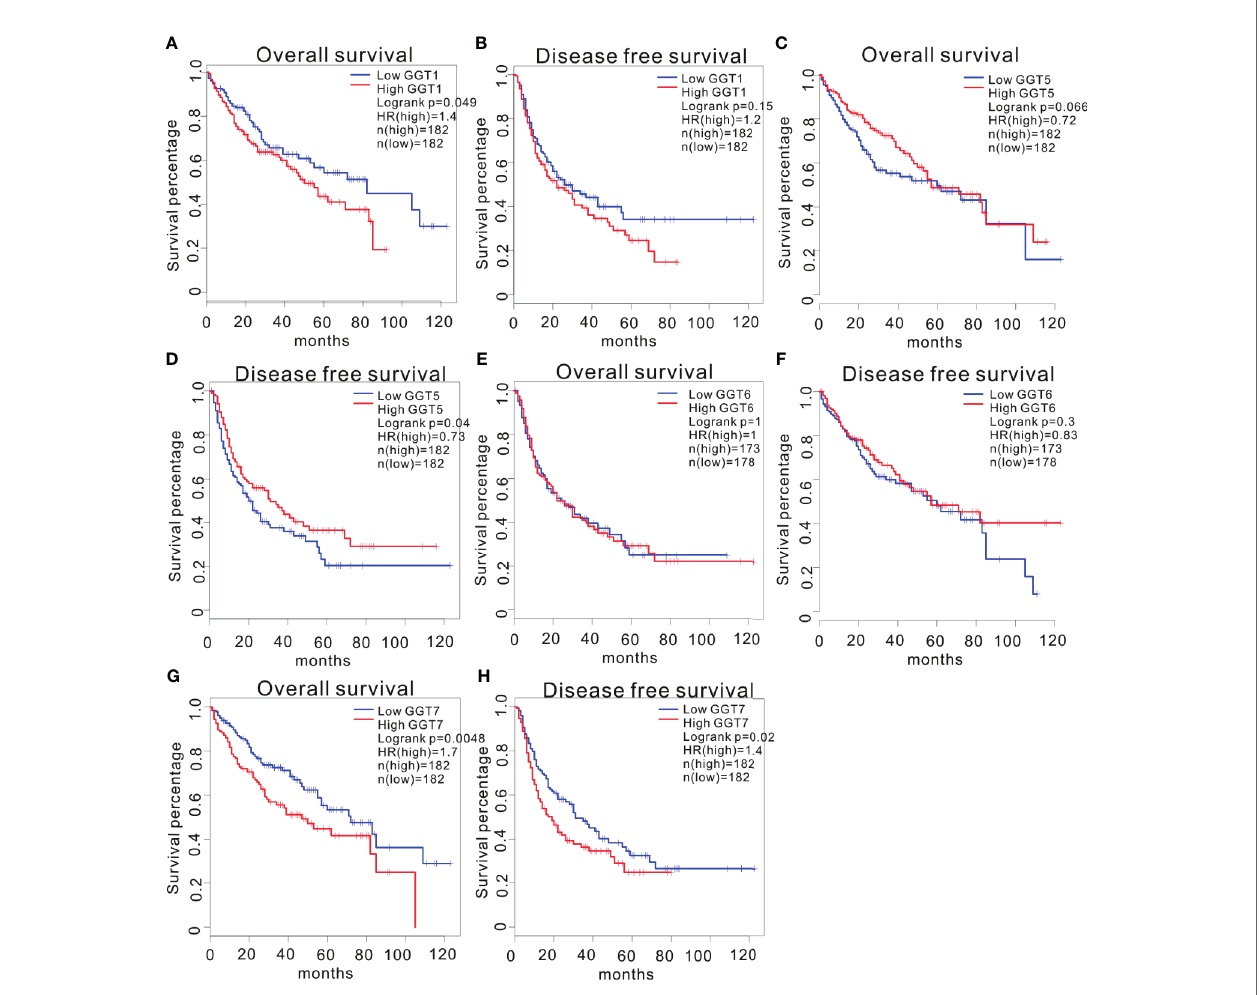
FIGURE 2 | Survival analysis of HCC patients strati fi ed by median expression value of GGT family genes, which were downloaded from GEPIA database. Association between GGT1 mRNA expression and overall survival (A) . Association between GGT1 mRNA expression and disease-free survival (B) . Association between GGT5 mRNA expression and overall survival (C) . Association between GGT5 mRNA expression and disease-free survival (D) . Association between GGT6 mRNA expression and overall survival (E) . Association between GGT6 mRNA expression and disease-free survival (F) . Association between GGT7 mRNA expression and overall survival (G) . Association between GGT7 mRNA expression and disease-free survival (H)